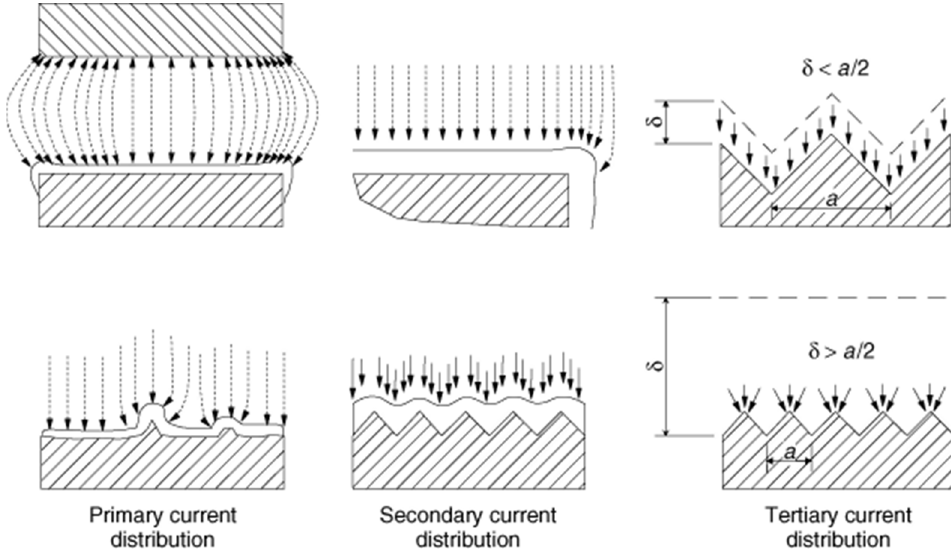
Figure 3. The effect of different current distributions (primary, secondary, and tertiary) on the electrodeposit thickness over the electrode surface. Reproduced with permission [16]. Copyright 2007, Wiley.